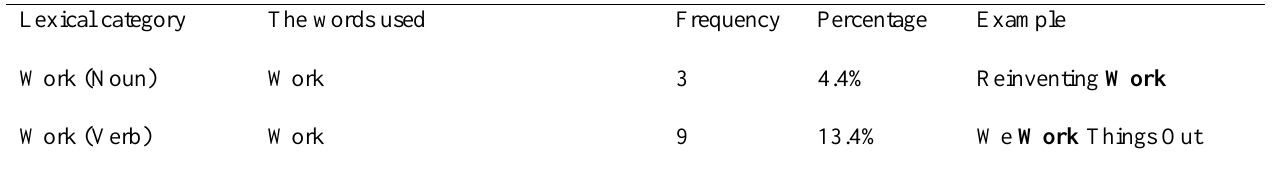
TABLE 2 | Lexical Category in Coworking Spaces Headlines Lexical